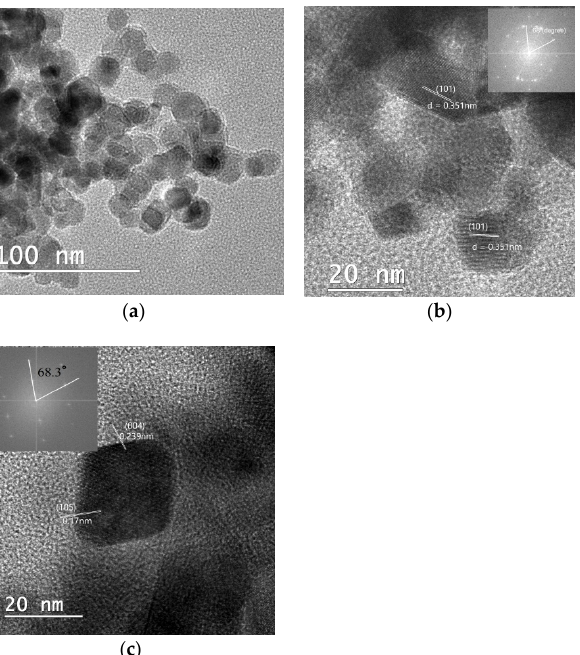
Figure 4. ( a ) TEM image of TiO 2 NSs; ( b , c ) HR-TEM images obtained from a small portion of ( a ); insert HR-TEM corresponding FFT image.